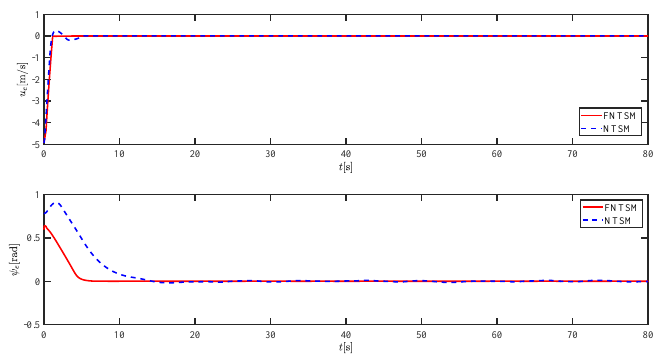
Figure 12. Sideslip angle estimations at fast speed.